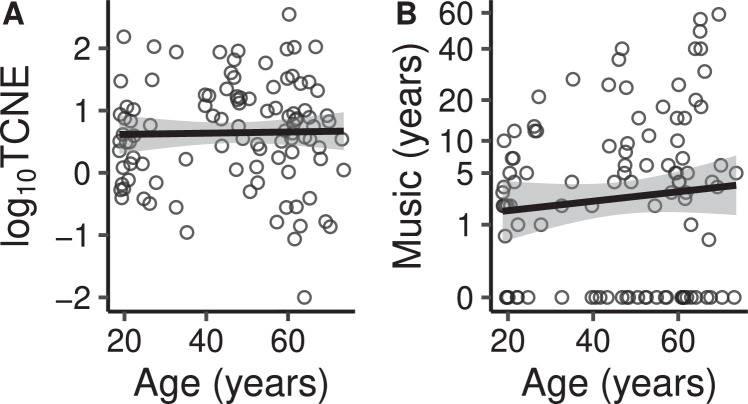
A. Total cumulative lifetime noise exposure as a function of age. A unit difference in the base 10 logarithmic y axis of the figure corresponds to a tenfold difference in noise exposure energy. B. Years of musical experience as a function of age. The y axis is shown on a cube root scale (years are displayed in their original unit).